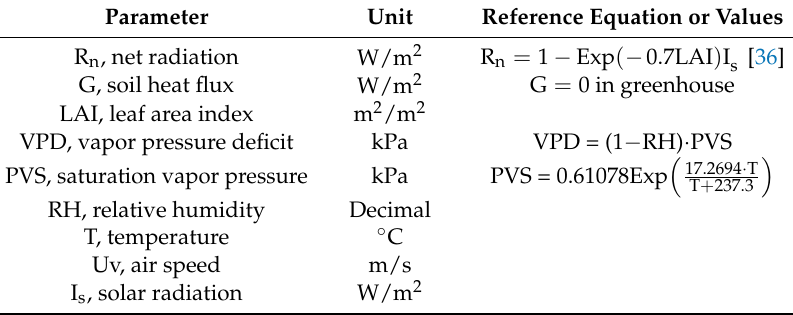
Table 2. Parameters of the evapotranspiration (ET)